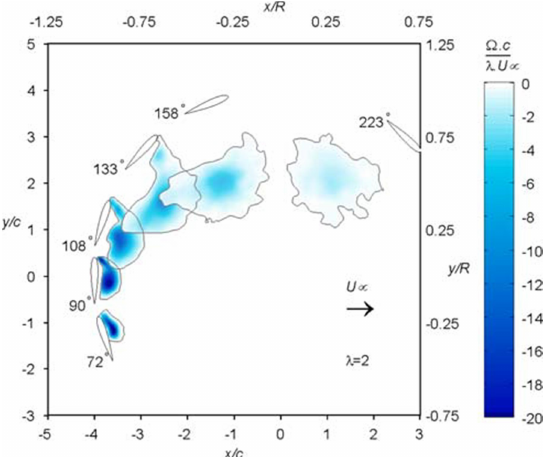
Figure 9. Evolution of the leading edge vortex circulation for different blade azimuthal positions. Image courtesy of Simão Ferreira et al.